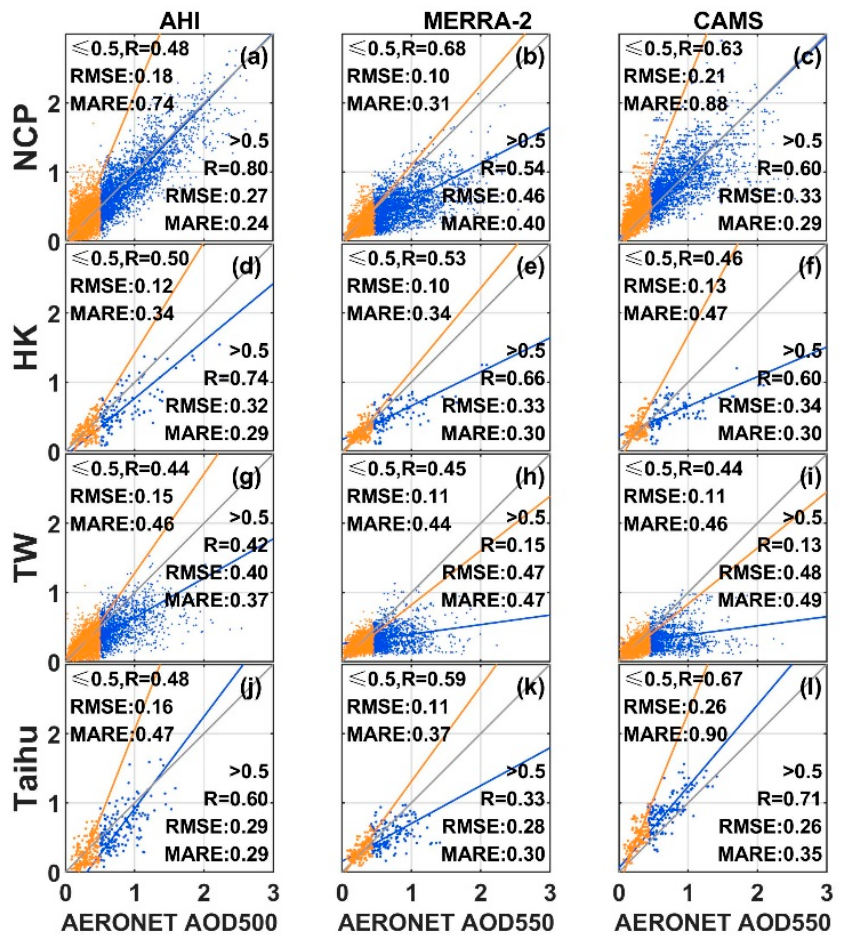
Figure 5. Scatterplots of AODs from AHI, MERRA-2, and CAMS versus AERONET observations in the ( a – c ) NCP, ( d – f ) HK, ( g – i ) TW, and ( j – l ) Taihu regions when AOD > 0.5 (in blue) and ≤ 0.5 (in orange), respectively. The y-axis of columns 1–3 indicates AODs from AHI, MERRA-2, and CAMS, respectively.